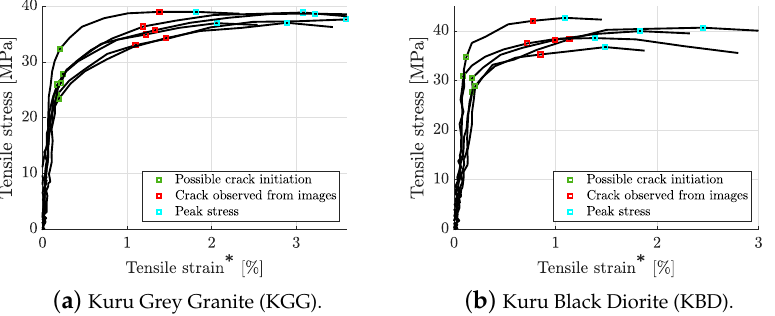
Figure 10. Dynamic indirect tensile stress versus tensile strain for the investigated rocks. The ∗ denotes that the use of the term strain after crack initiation is dubious since the measurement is only valid up until the instant of